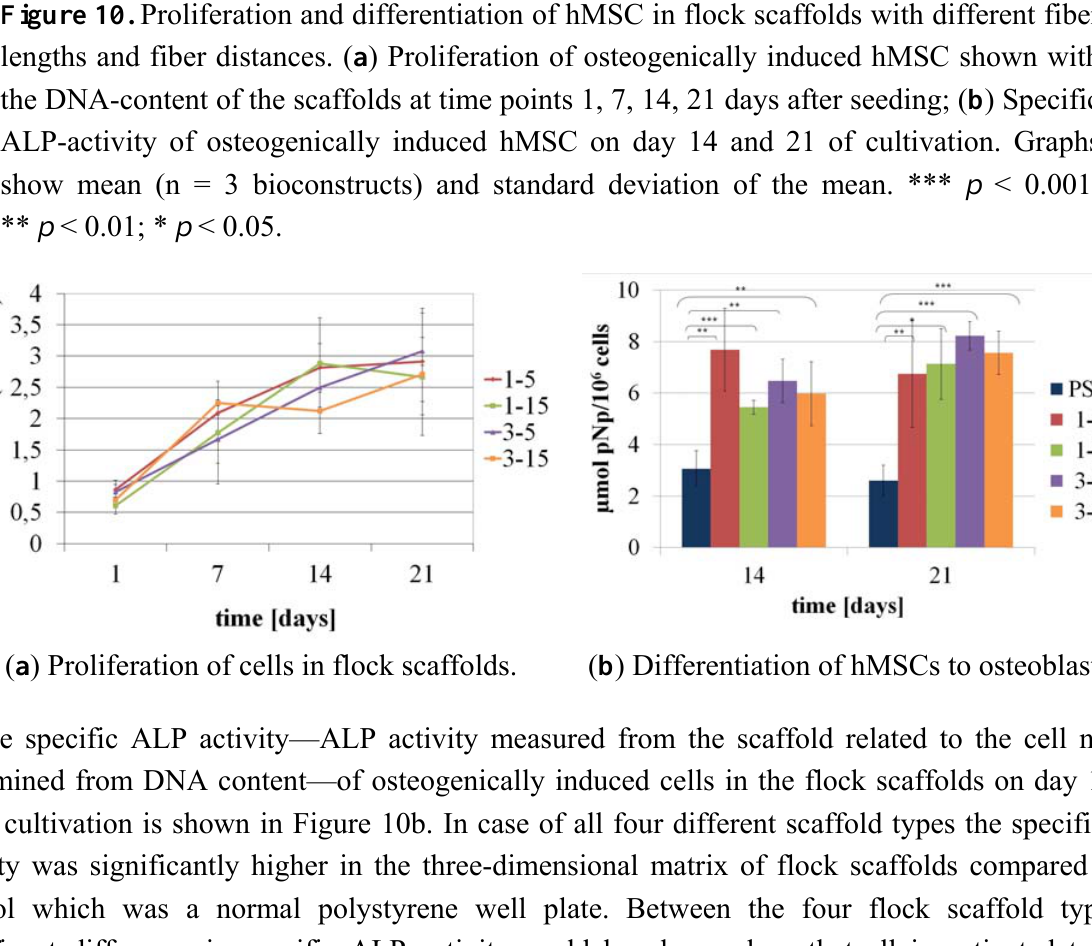
Figure 10. Proliferation and differentiation of hMSC in flock scaffolds with different fiber lengths and fiber distances. ( a ) Proliferation of osteogenically induced hMSC shown with the DNA-content of the scaffolds at time points 1, 7, 14, 21 days after seeding; ( b ) Specific ALP-activity of osteogenically induced hMSC on day 14 and 21 of cultivation. Graphs show mean (n = 3 bioconstructs) and standard deviation of the mean. *** p < 0.001; ** p < 0.01; * p < 0.05.